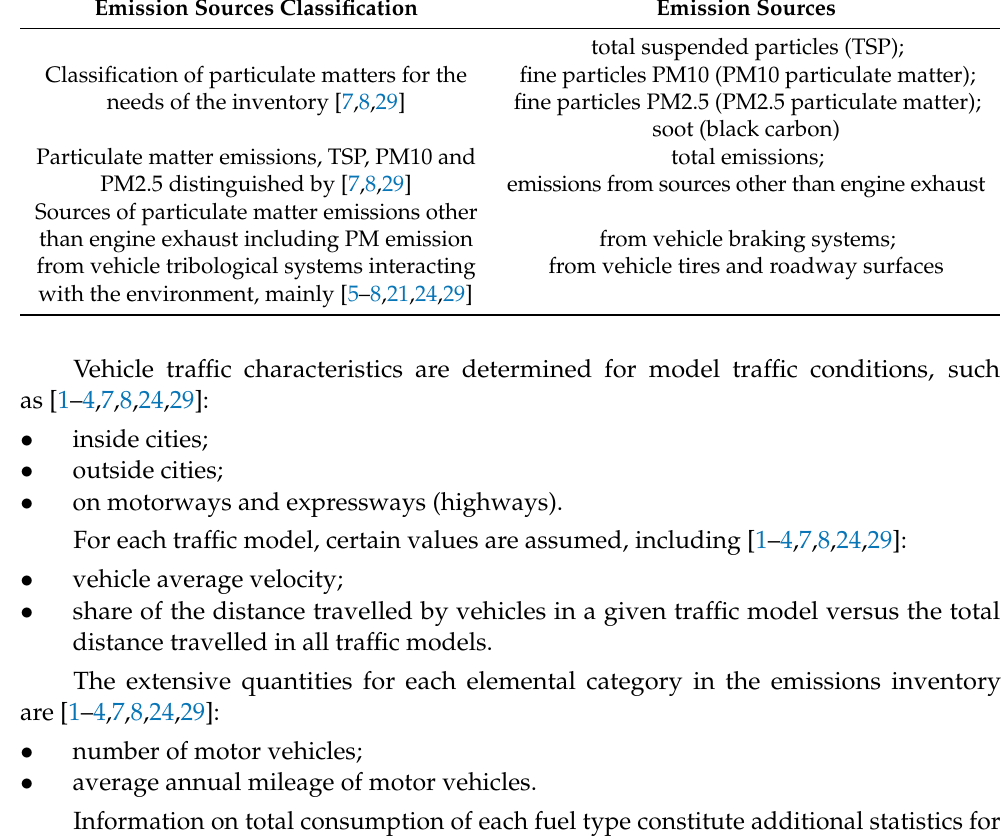
Table 3. Different classifications of particulate matters and their emission sources. Sources of Particulate Matters or Their Emission Sources Classification Classification of particulate matters for the needs of the inventory [7,8,29] Particulate matter emissions, TSP, PM10 and PM2.5 distinguished by [7,8,29] Sources of particulate matter emissions other than engine exhaust including PM